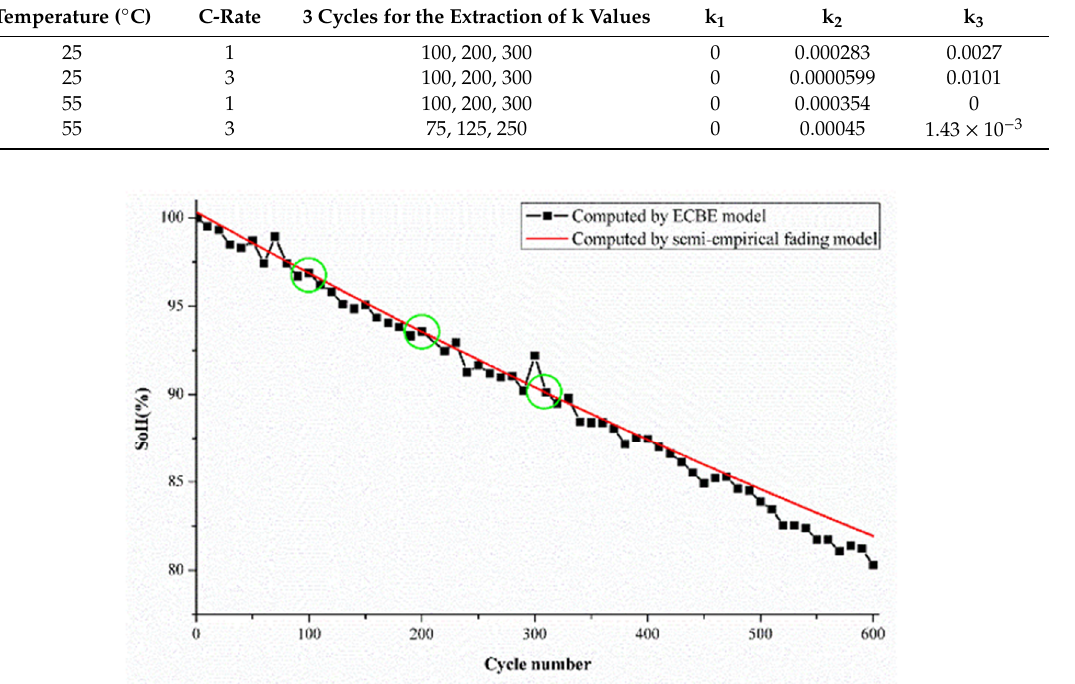
Figure 2. State-of-health (SoH) estimation results from ECBE model (black curve) and semi-empirical fading model (red curve) for battery tested at 55 °C and 1 C discharge current. Green circle represents the points used to find the k values.